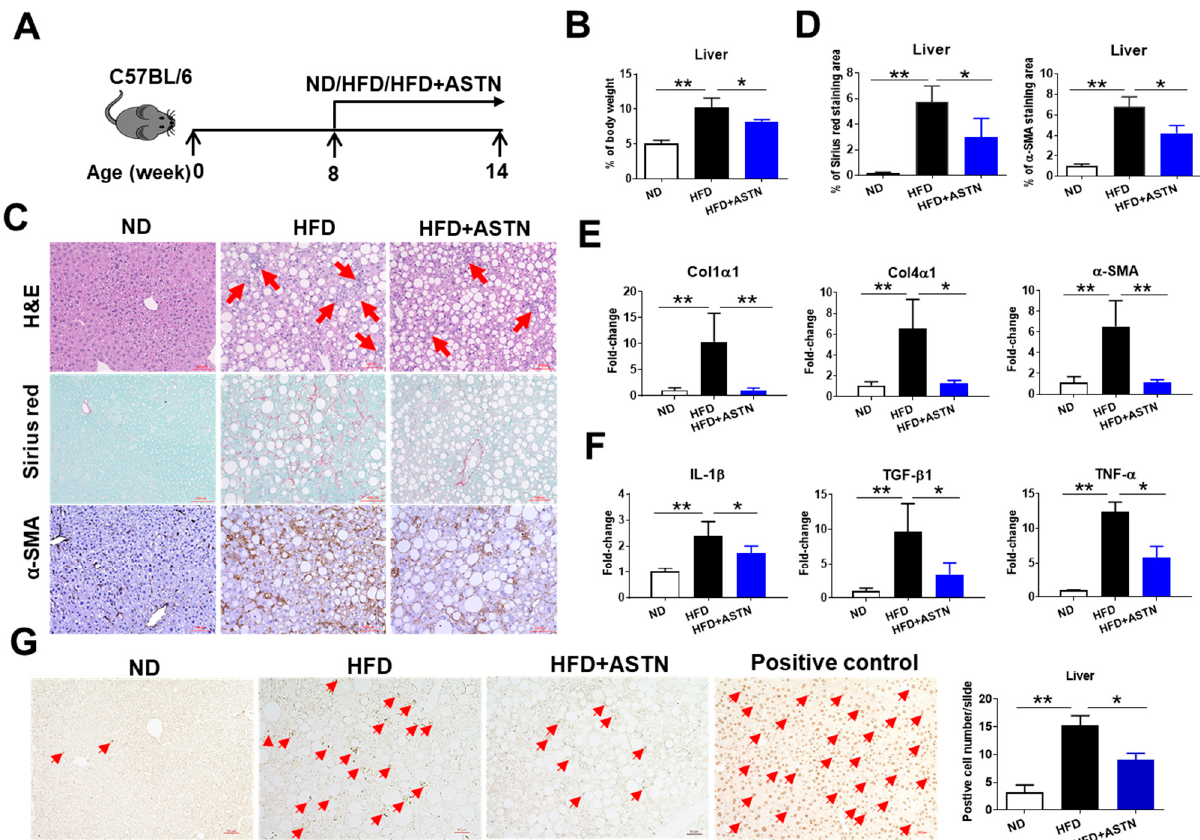
Figure 3. Astaxanthin treatment slows the development of HFD-induced NASH. ( A ) An outline depicting ASTN treatment design. Eight-week-old WT C57BL/6 mice were fed with a HFD for 6 weeks with or without receiving simultaneous ASTN treatment, at a dose of 80 mg/Kg of bodyweight. WT mice fed with ND were used for control. ( B ) Effect of ASTN on HFD-caused the increase in the ratios of liver-to-bodyweight. Compared to ND, HFD caused the increase in the ratio of liver-to-bodyweight which was suppressed by ASTN treatment. ( C ) Effect of ASTN on HFD-induced NASH. Compared to nontreatment, ASTN treatment led to the obvious reduction in the liver infiltration of inflammatory cells (red arrow, H&E staining) and production of the collagen (Sirius red staining) and α -SMA (IHC detection) in HFD-fed mice. Bar scale: 100 μ m. ( D ) Semi-quantification of collagen production and α -SMA protein expression in the livers of three groups of mice as shown in ( C ). ( E ) ASTN reduced hepatic mRNA expression of ECM genes in HFD-fed mice. qPCR measured the reduced mRNA expression of Col1 α 1 , Col4 α 1 , and α -SMA genes in the livers of ASTN-treated mice compared to nontreatment mice. ( F ) ASTN reduced hepatic mRNA expression of proinflammatory and profibrotic cytokines. qPCR measured the reduced mRNA expression of IL-1 β , TGF- β 1 , and TNF- α genes in the livers of ASTN-treated mice compared to nontreatment mice. ( G ) ASTN suppressed hepatocyte death (red arrows). Bar scale: 50 μ m. Representative and accumulated results from the TUNEL assay indicated that ASTN treatment reduced dead hepatocytes in the livers of HFD-fed mice. n = 5, error bars represent the mean ± SD. Statistical analysis of data was performed by one-way analysis of variance (ANOVA) using GraphPad Prism 8 software. ** p < 0.01, * p < 0.05.